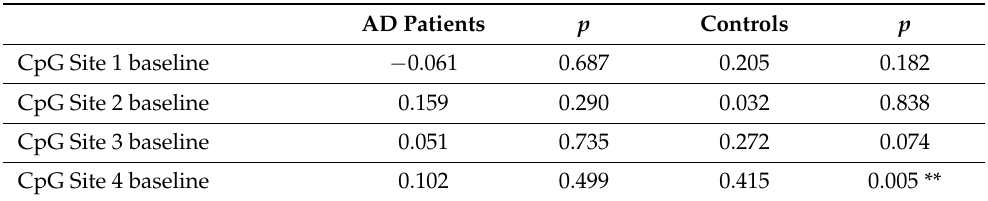
Table 2. Correlation between Age and Baseline GABRA2 CpG Methylation in Alcohol-dependent Individuals and Controls (Spearman’s rho). AD Patients p Controls p CpG Site 1 baseline